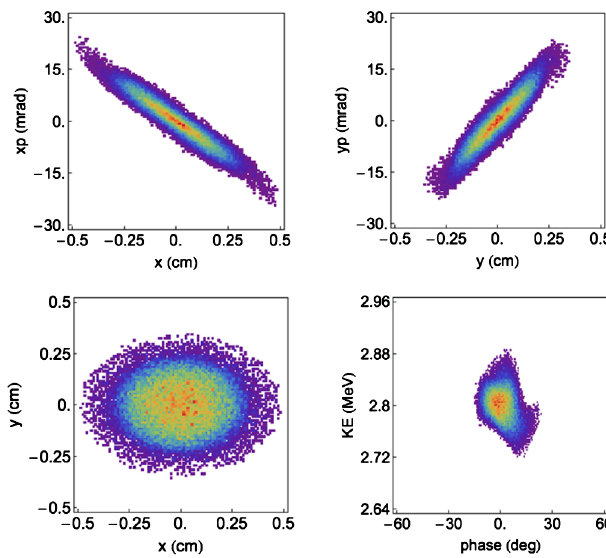
FIG. 19. PARMELA phase-space plots of a Gaussian bunch with 50 K particles at the IH1m tank exit.